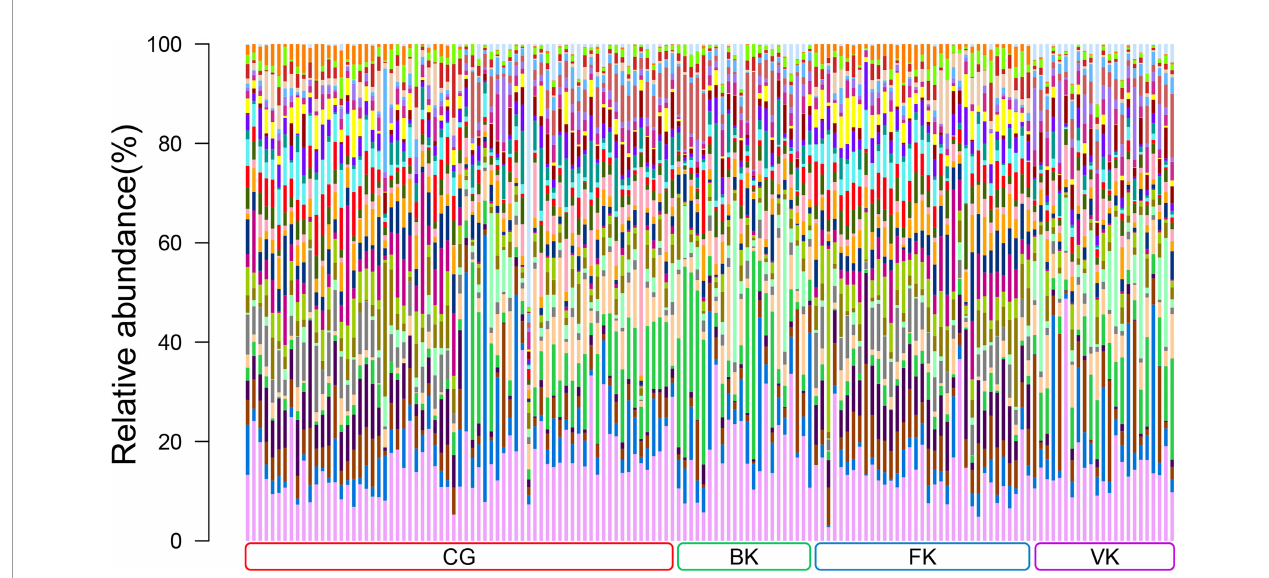
FIGURE 1 | Relative abundances of the top 30 bacterial genera in the conjunctival microbiota. Each bar represents a sample of conjunctival microbiota, various color portions represent different genera, and the length of a colored portion represents the content of a genus. Among the 149 samples, 69 were from healthy eyes (CG), 22 were from bacterial keratitis (BK), 35 were from fungal keratitis (FK), and 23 were from viral keratitis (VK). Different samples possess diverse ocular surface